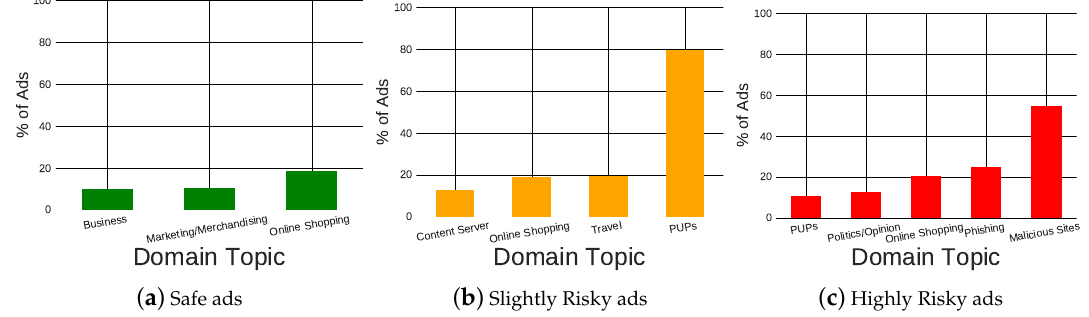
Figure 3. This figure is a bar plot that shows the McAfee domain topics that are related to more than 10% of the ad impressions in our dataset for: Safe ads, Slightly Risky ads and Very Risky ads. The x axis shows the topics and the y axis the presence of each topic in percentage. The sum of percentages in a specific group of ads could go beyond 100% because McAfee may label a domain using up to three topic labels, thus an ad impression may be linked to up to three